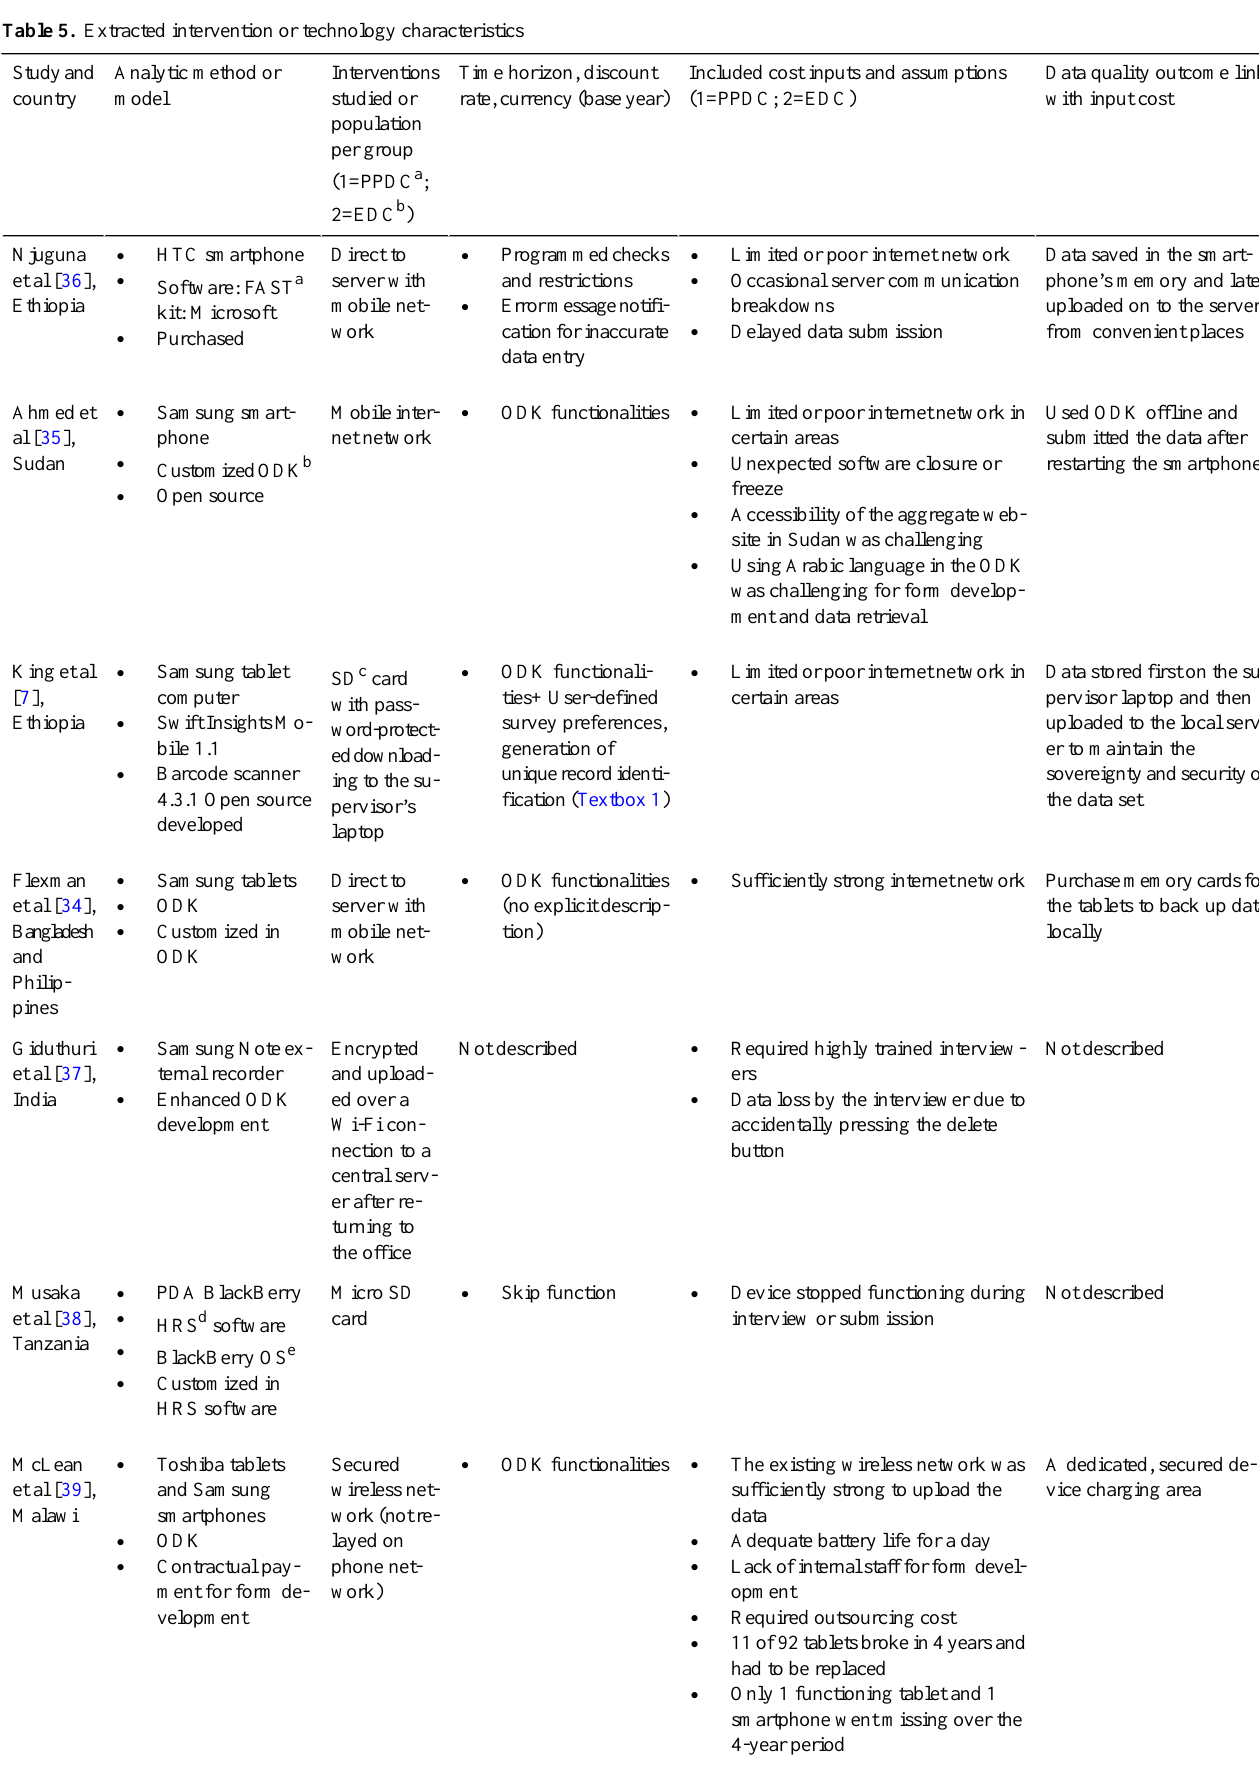
Table 5. Extracted intervention or technology characteristics